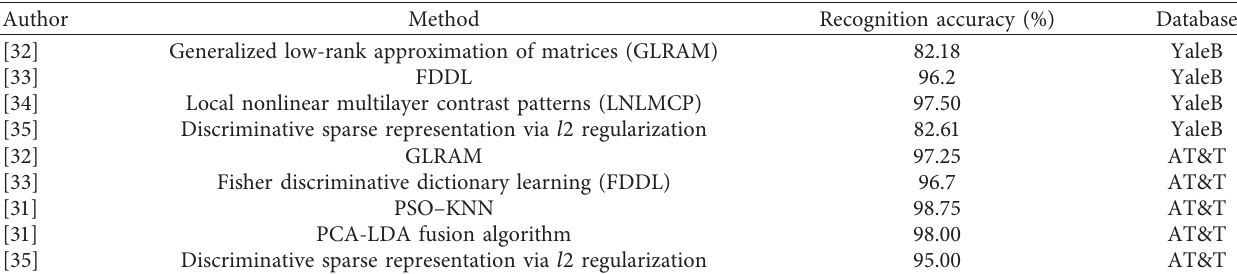
Table 10: Recognition accuracy of other methods on the YaleB and AT&T